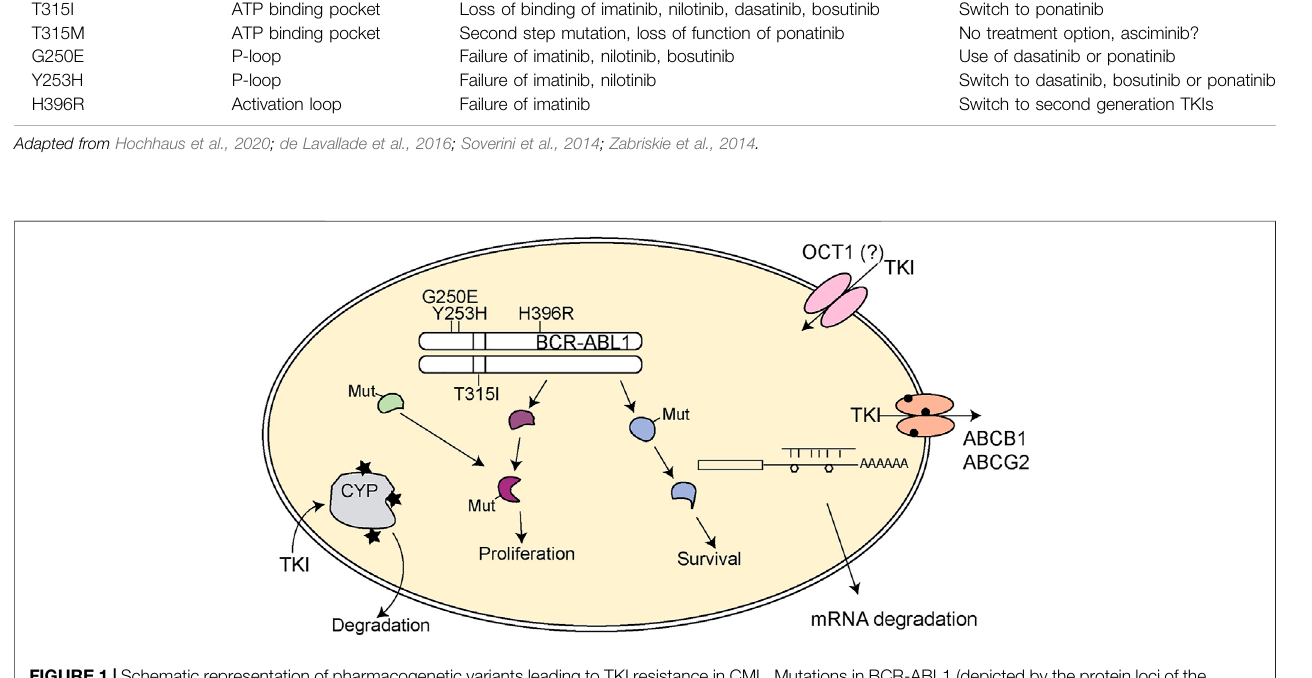
( Table 2 ; Figure 1 ). This is also the case for patients with intolerance to one distinct TKIs.